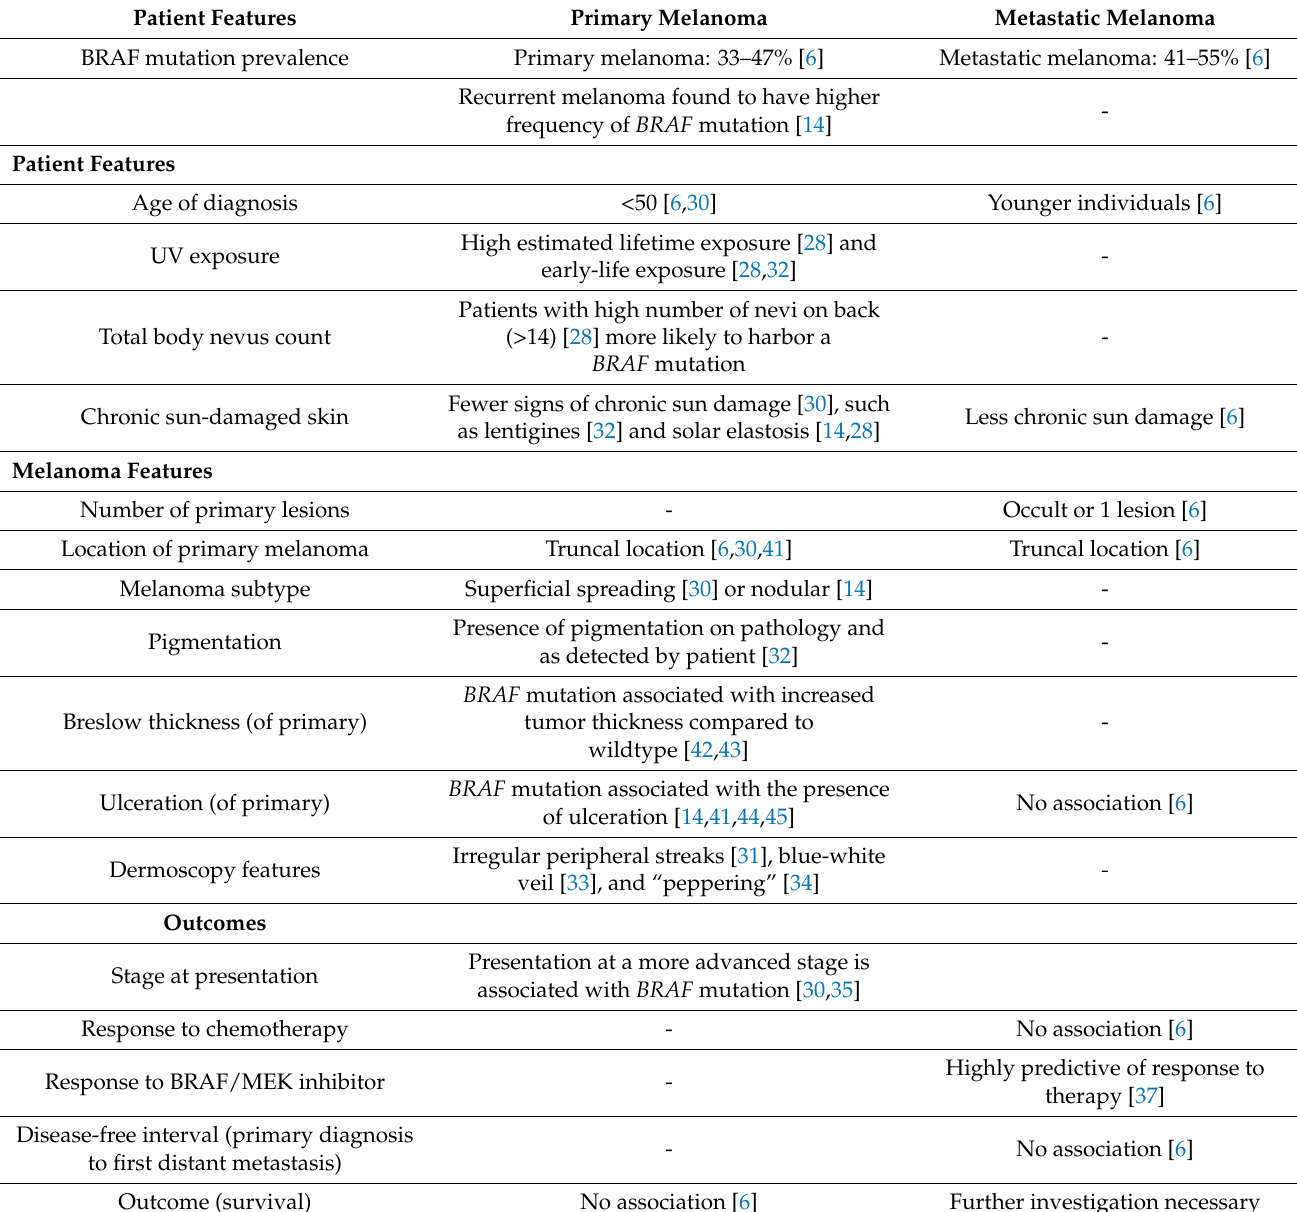
Table 1. Frequently reported features of melanoma found to be associated with BRAF mutation